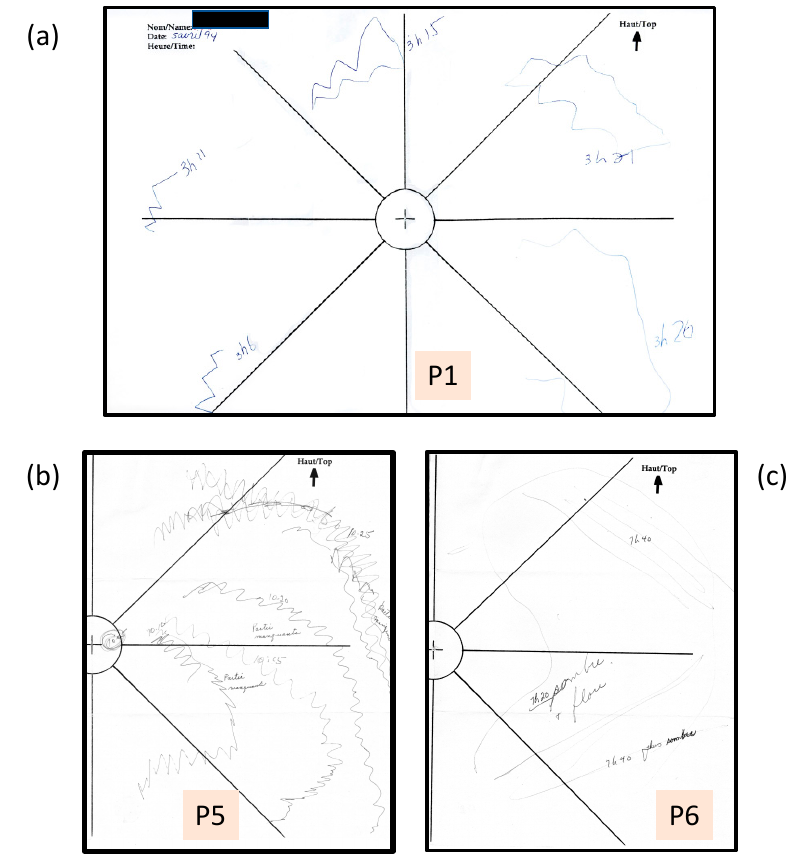
Figure 1. ( a ) P1: Example of a full aura map tracking a visual aura at five intervals between 3:06 and 3:26 pm. When in use, a 40 cm string attached to the centre of the central fixation cross (not shown here) was used to maintain the correct viewing distance. The observer drew the aura patterns while fixating the + at the centre of the map and labelled each observation with the time. ( b ). P5: One example of a fortification aura in the right visual field drawn between 10:05 and 10:25 am. Only half the map is shown as nothing was recorded in the left visual field. Missing parts (“partie manquante”) are indicated in the wake of the positive symptoms. ( c ) P6: An example of a negative aura drawn at two time intervals, noting that the drawn region is dark and blurry (“sombre and flou”), and at 7:40 darker (“plus sombre”).